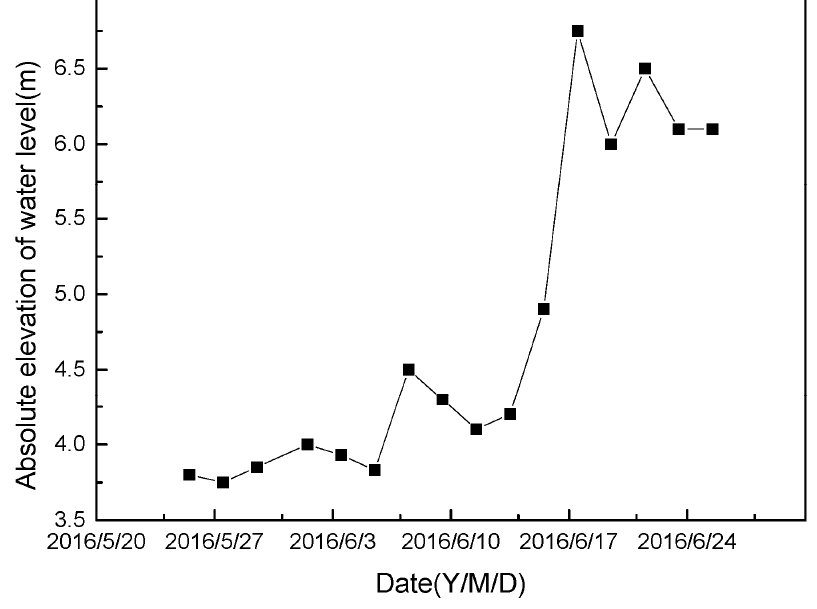
Figure 13. Water observation curve.